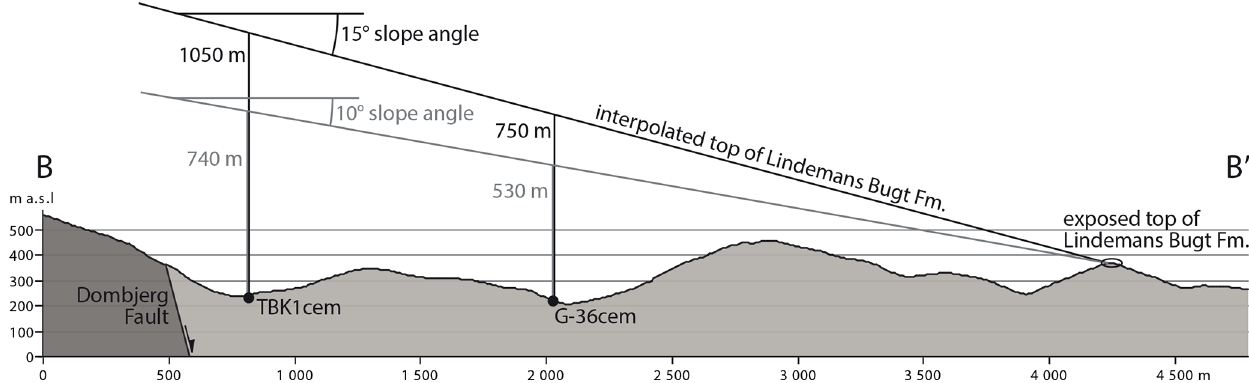
Figure 11. Estimation of thickness of Lindemans Bugt Formation above sample sites. A slope angle of 10–15 ◦ is reported for fault-proximal sediments (Henstra et al., 2016) and is used as an interpolation of the top of the formation from its exposure in the field towards the Dombjerg Fault. Sample sites are interpolated onto the profile. For the location of the profile, see Fig. 2.